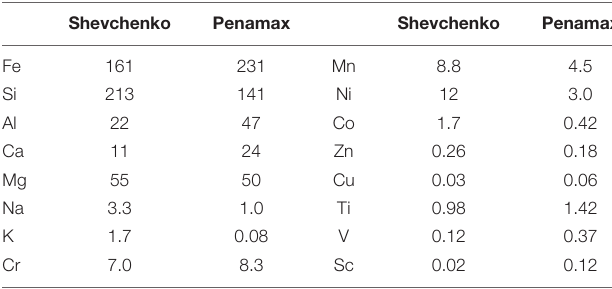
TABLE 1 | Elemental* and mineralogical** compositions of the limonite samples